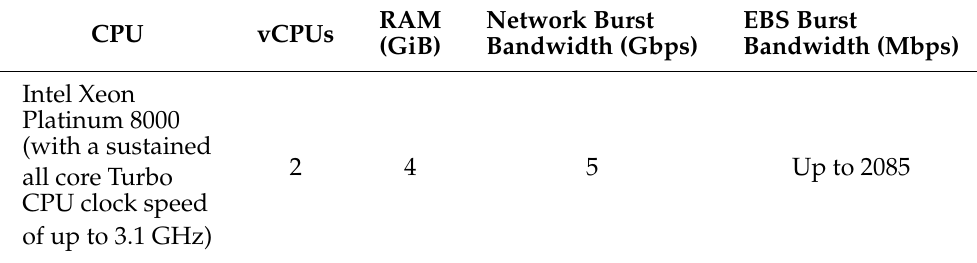
Table 5. Details of the Machine used on the Amazon Elastic Compute Cloud